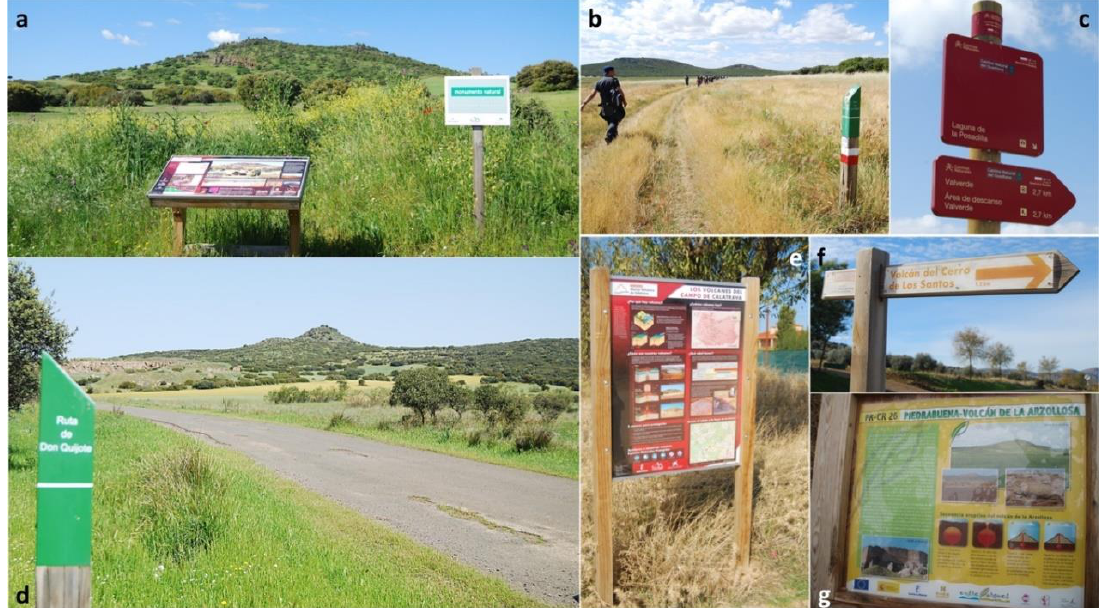
Figure 17. Some examples of georoutes, itineraries and hiking trails through protected volcanoes: ( a ) La Conejera volcano; ( b ) Peñarroya maar; ( c ) signs to La Posadilla maar; ( d ) Morrón de Villamayor volcano and Don Quijote Route; ( e – g ) information panels and signs to some volcanic natural